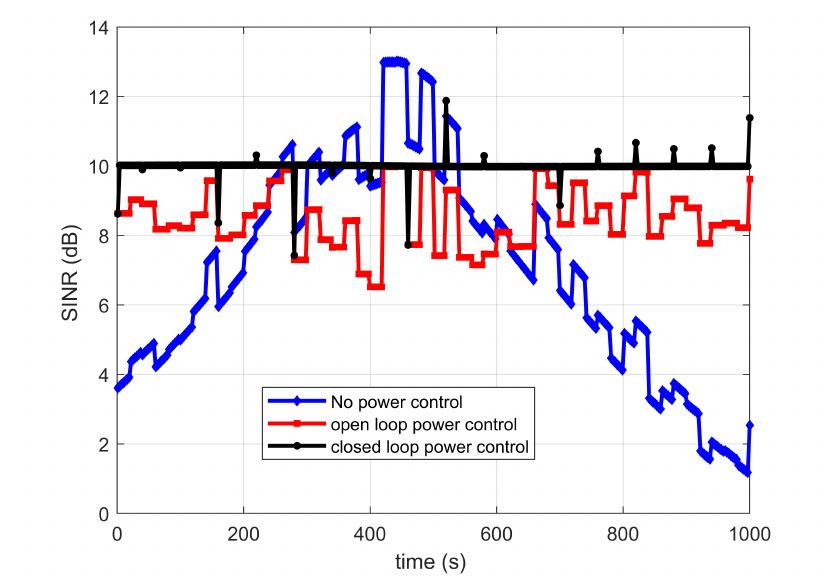
Figure 9. SINR for link between satellite 2 and IoT terminal versus